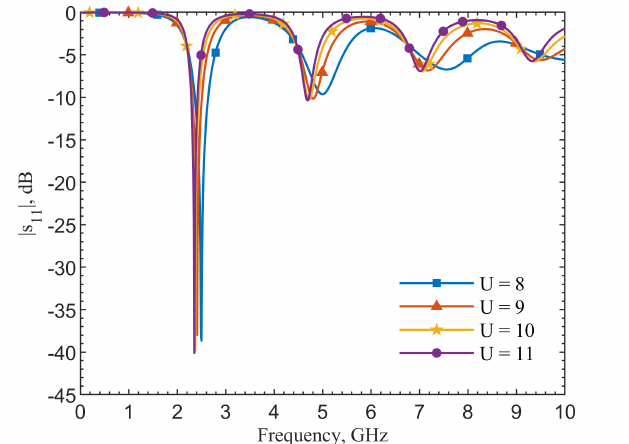
Figure 15. Comparison of tuned-loop resonators with U from 8 to